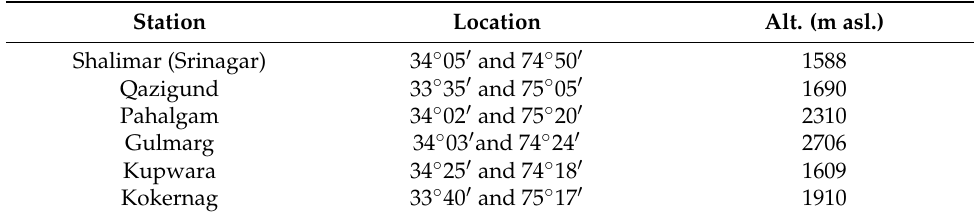
Table 1. Details of different stations of Kashmir